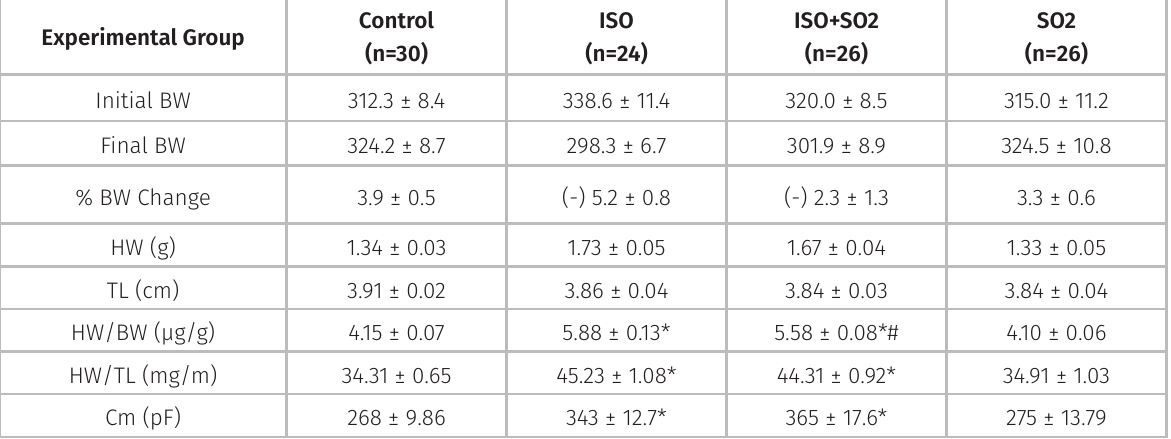
Table I. Morphological parameters of animals. Experimental Group